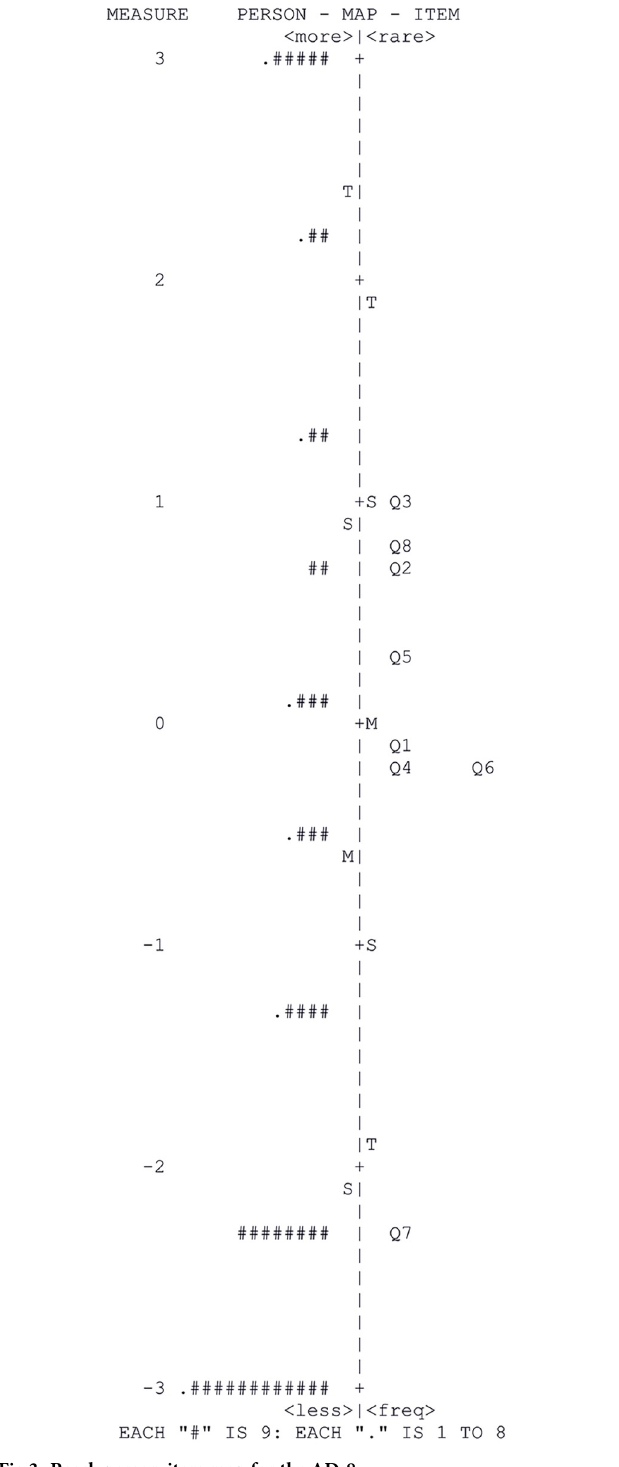
Fig 3. Rasch person-item map for the